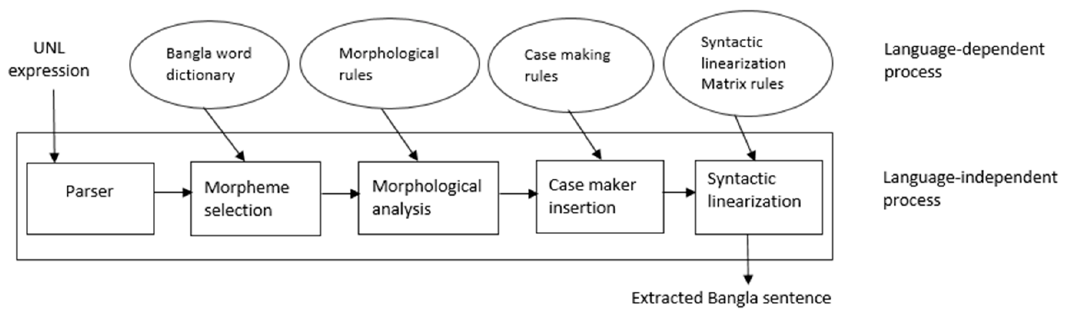
Figure 2. Architecture of Bangla DeConverter for Universal Networking Language.